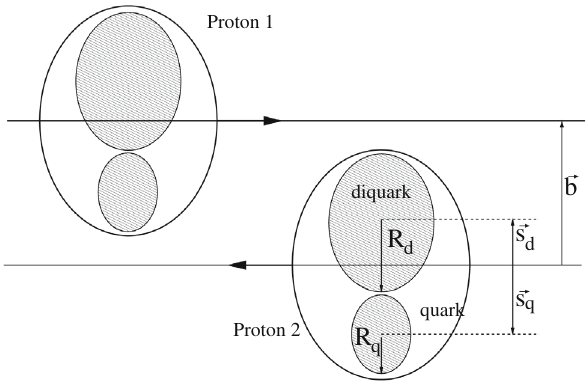
Fig. 20 Visualization of the proton–proton scattering in the quark– diquark BB model. The figure is taken from Ref. [33]